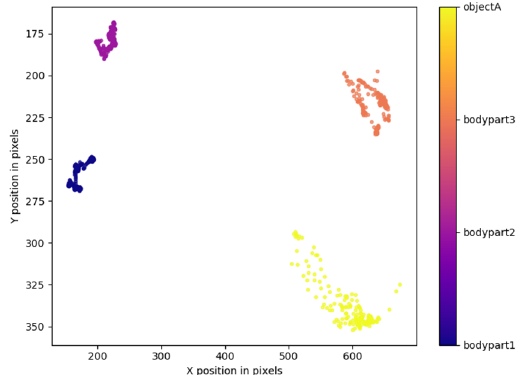
Figure 4. Spatial and temporal distribution characteristics of multi-characteristic points of dairy cow protective behavior. The spatial distribution of the feature points of different poses retains morpho- logical characteristics during the movement. Thus, by using the information of the distributions of these feature points in space, their behavior categories can be identified more